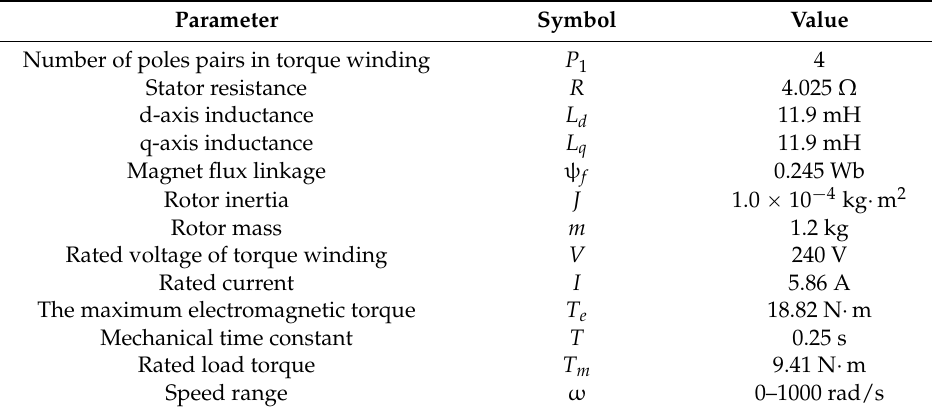
Figure 1. Configuration of the vector control system based on improved SRUKF. Table 1. Parameter of